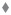
Input Bayesian phylogeny of the (a) savannah and (b) tropical forest ecosystems for the program Phylocom based on the gene cytochrome oxidase II.Occurrence of species: ♦ = in both regimes; ● = protected only; □ = disturbed only.